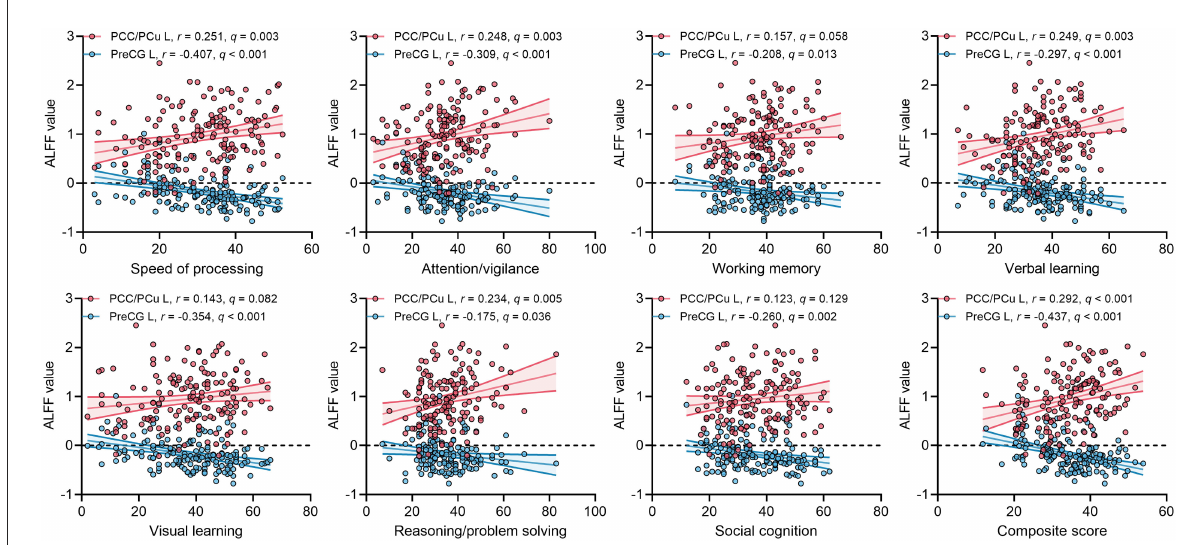
FIGURE3 Correlations between ALFF values of two ROIs and MCCB cognitive scores in ECS. q, p -values corrected by FDR correction. Abbreviations: ALFF, amplitude of low-frequency fluctuations; ECS, early course schizophrenia; MCCB, MATRICS Consensus Cognitive Battery; PCC/PCu, posterior cingulate cortex/precuneus; PreCG, precentral gyrus; ROI, region of interest; FDR, false discovery rate; L,